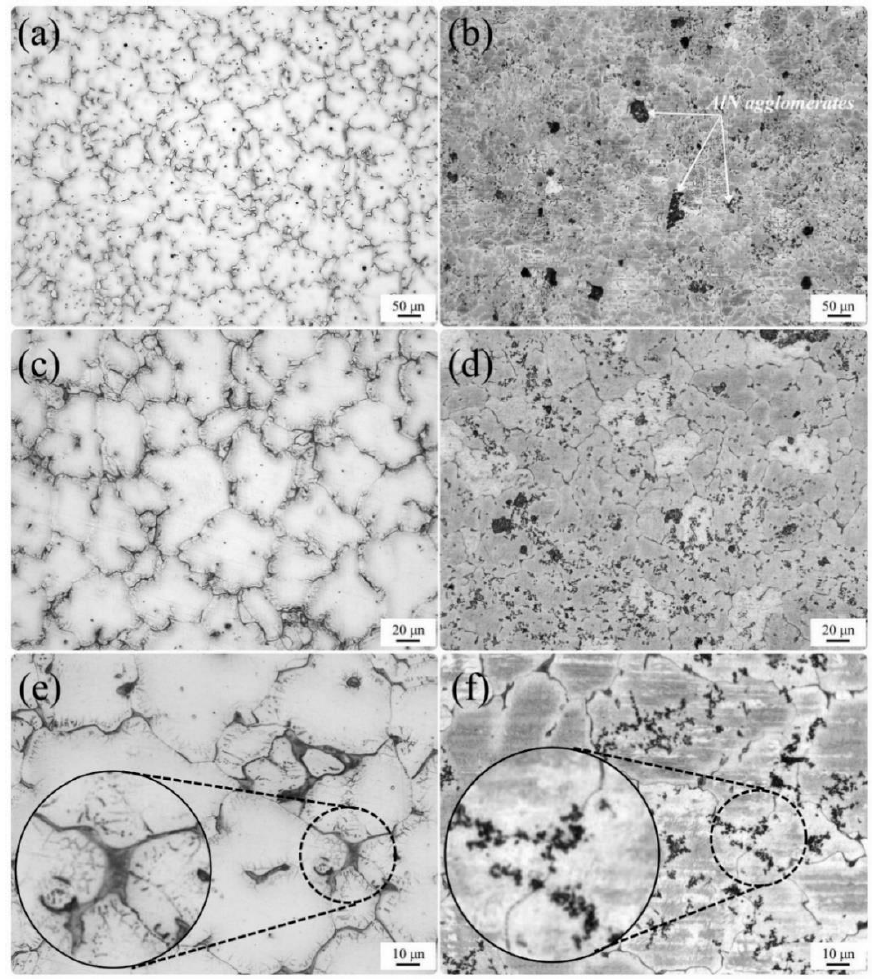
Figure 1. Optical micrograph of ( a , c , e ) as-cast modified EV31, ( b , d , f ) as-cast modified EV31-2%AlN.